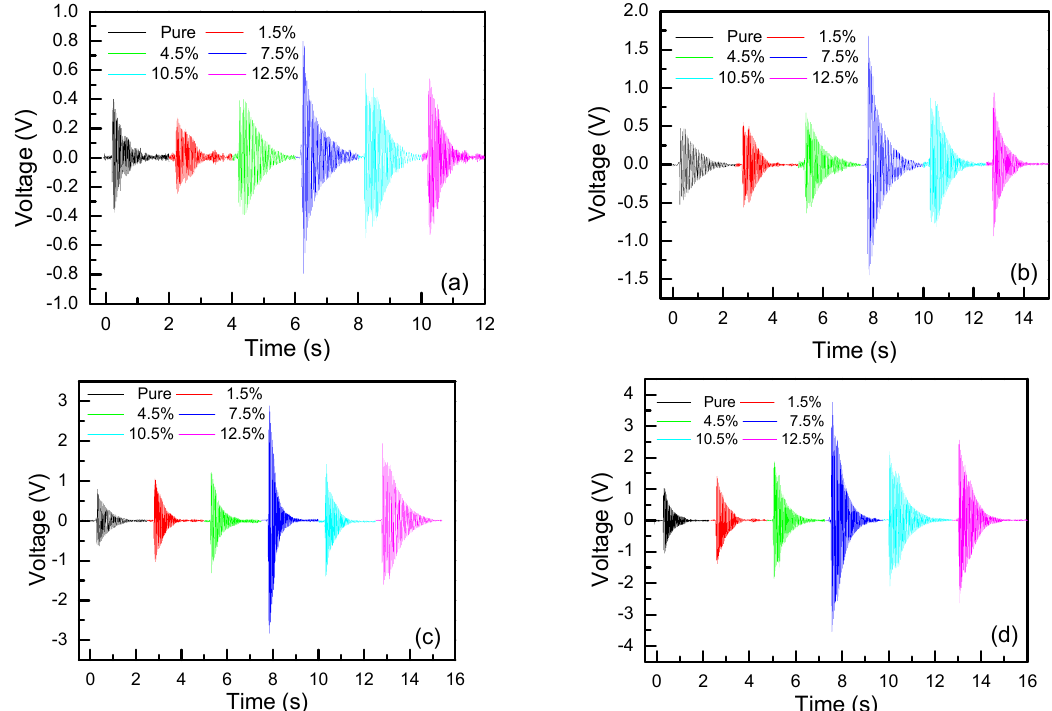
Figure 10. The output signals of PVDF-TrFE/nano-ZnO films with different nano-ZnO contents under different impact energy: ( a ) 54 mJ impact energy; ( b ) 109 mJ impact energy; ( c ) 219 mJ impact energy; and ( d ) 329 mJ impact energy.